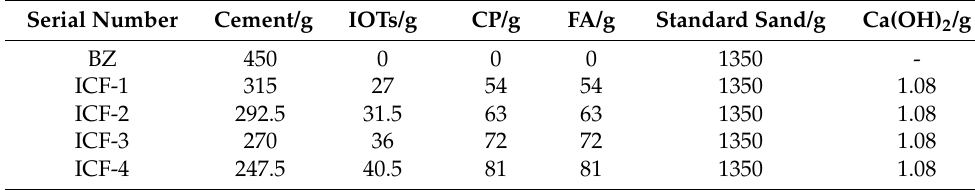
Table 3. Cement mortar ratio of group A. Serial Number Cement/g